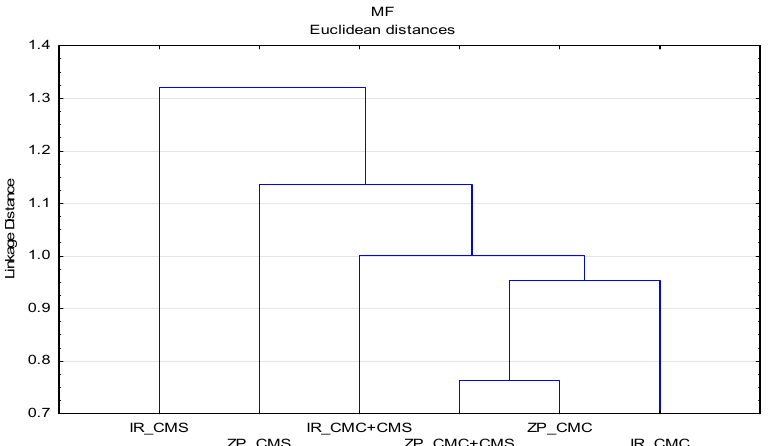
Figure 8. Dendrogram of the zeta potential (ZP) and incineration residue (IR) data of MF as a function of impact of SMs.